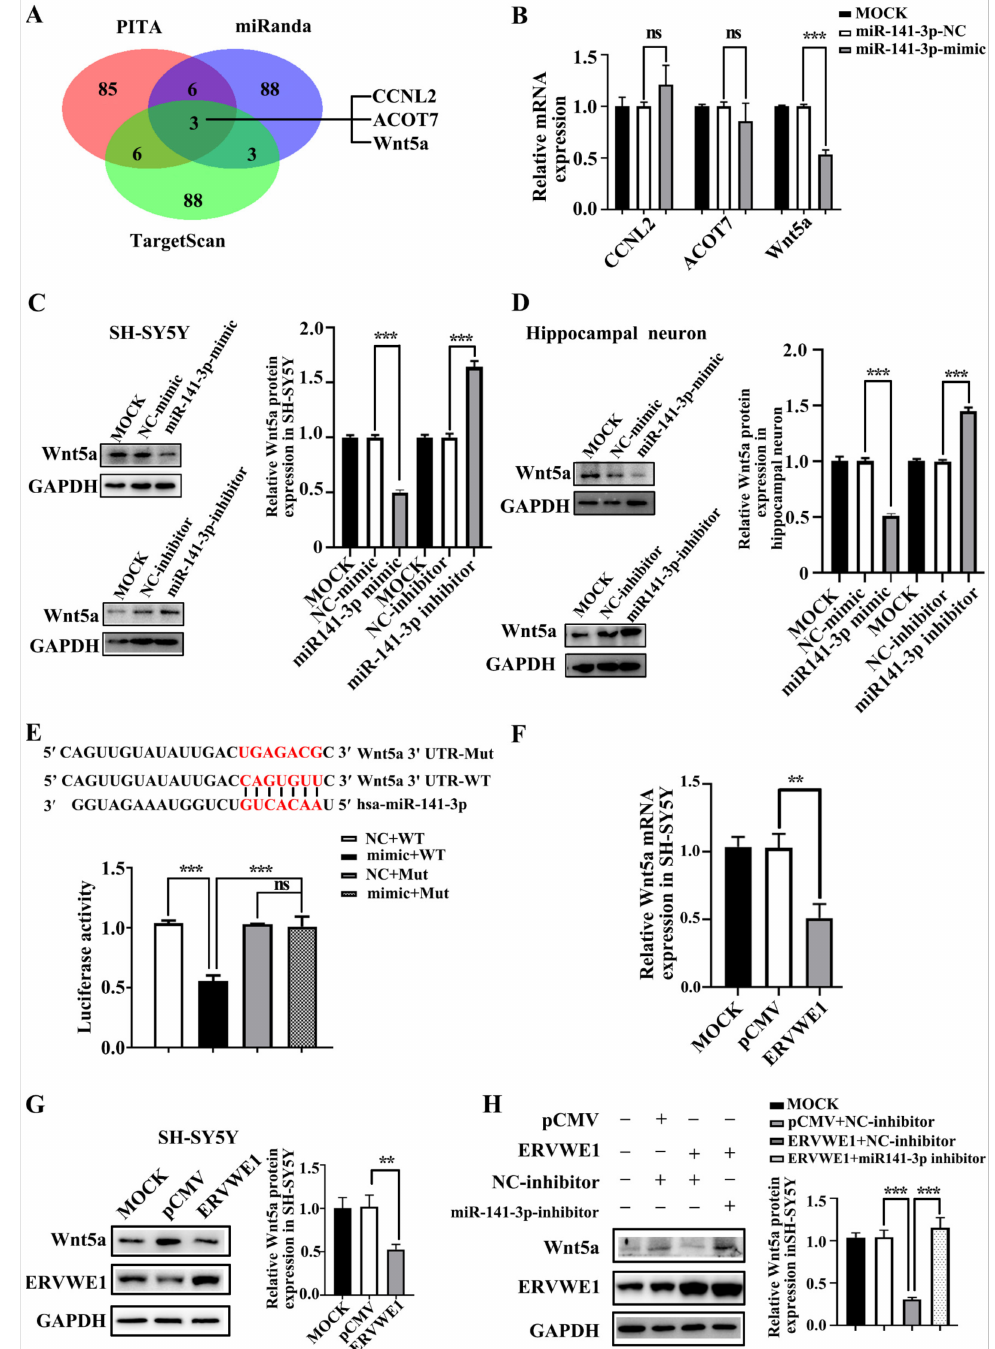
Figure 3. ERVWE1 reduced the expression of Wnt5a through miR-141-3p. ( A ) The prediction results showed that CCNL2, ACOT7, and Wnt5a might be the potential target genes of miR- 141-3p. ( B ) RT-qPCR indicated that miR-141-3p mimic inhibited the mRNA expression of Wnt5a. ( C,D ) miR-141-3p mimic decreased the protein level of Wnt5a, and miR-141-3p inhibitor up-regulated the expression of Wnt5a in SH-SY5Y cells and rat hippocampal neurons. ( E ) MiR-141-3p down- regulated the expression of Wnt5a through its 3 (cid:48) UTR. ( F ) The decreased level of Wnt5a was de- termined by RT-qPCR in SH-SY5Y cells. ( G ) ERVWE1 down-regulated the expression of Wnt5a in SH-SY5Y cells, the protein level was detected by western blot. ( H ) Knockdown of miR-141-3p substantially elevated the ERVWE1-induced protein expression of Wnt5a, the protein level was detected by western blot in SH-SY5Y cells. *** p < 0.001, ** p < 0.01, ns: p >